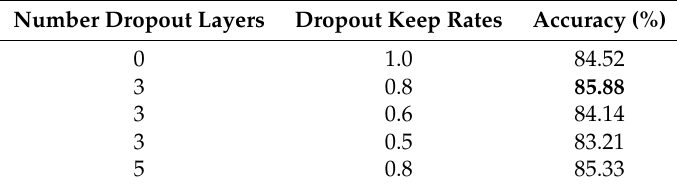
Table 3. Comparison of different dropout keep rates and dropout layers of ML-xResNets in accuracy, the best result is in